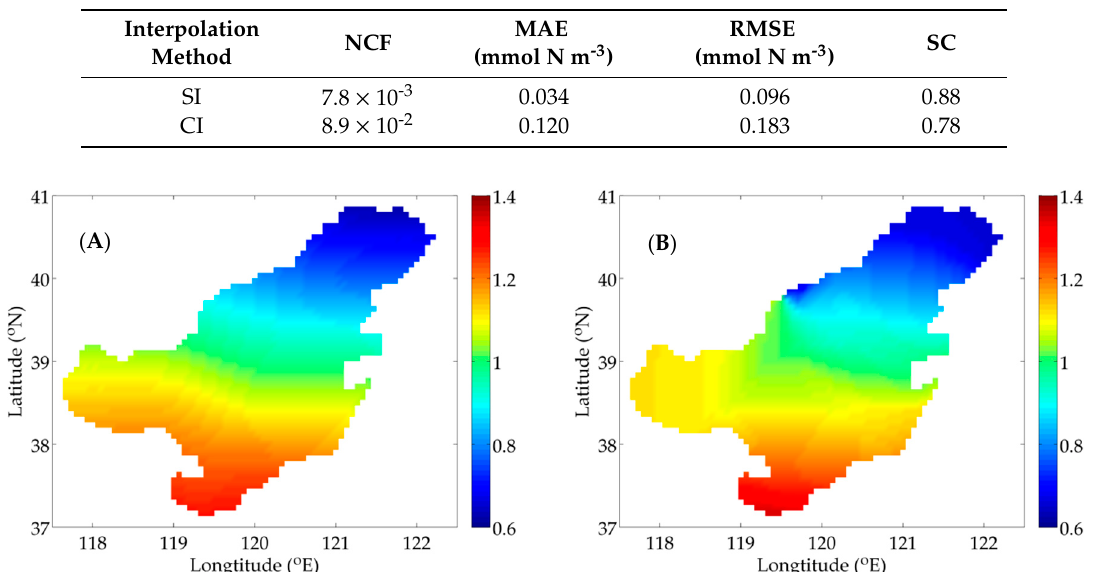
Table 3. The results of the quantitative metrics using two interpolation methods in the idealized twin experiment 2 (IE2).